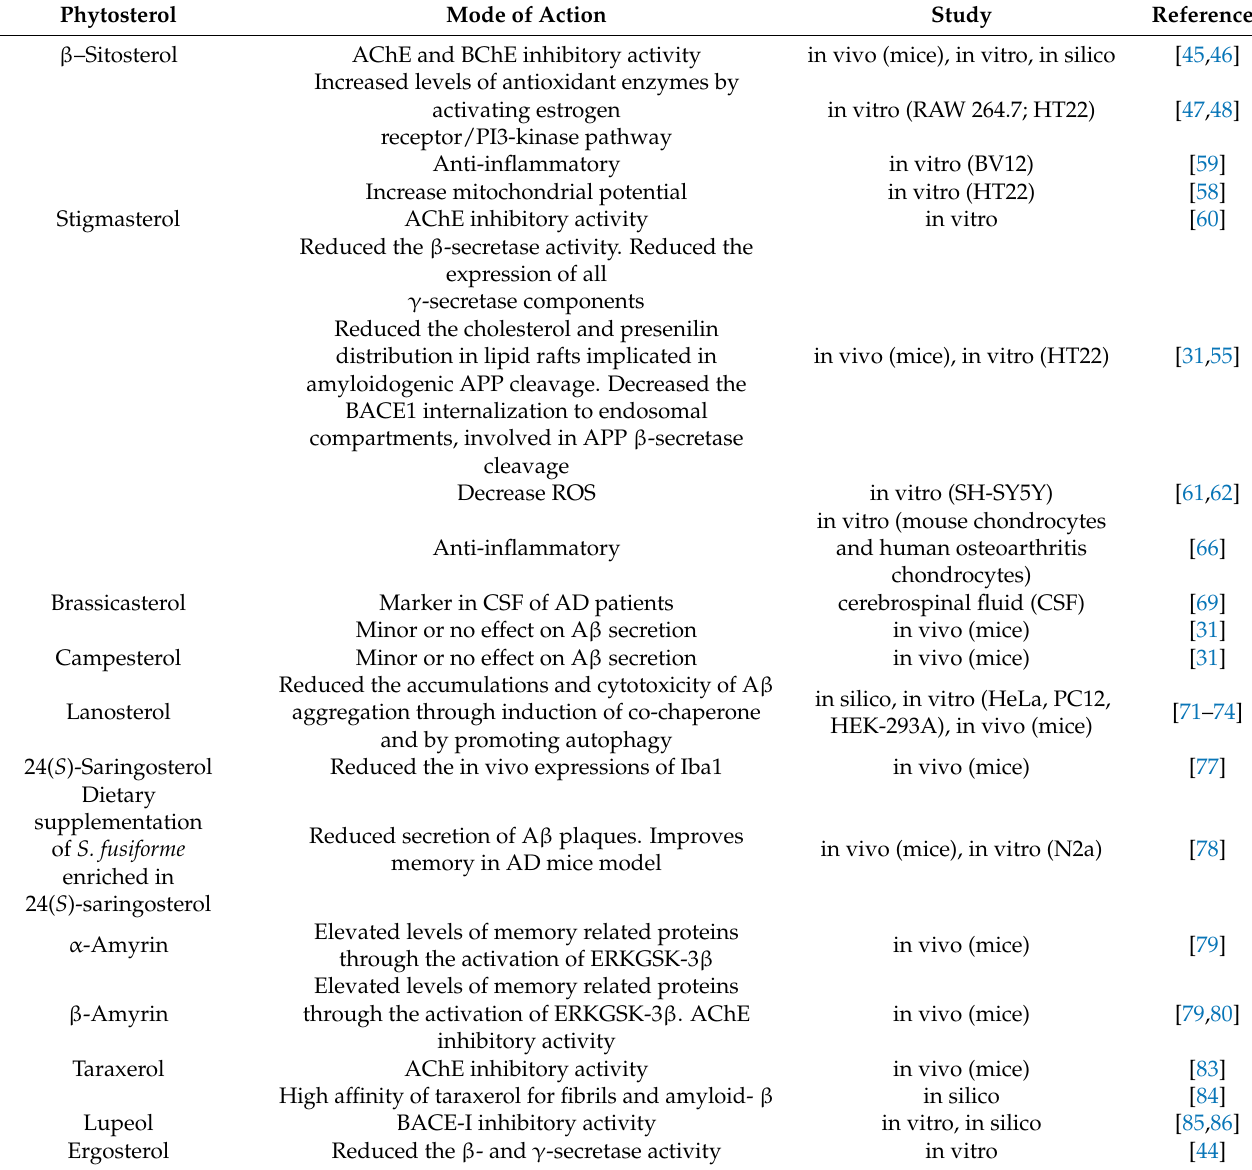
Table 1. Neuroprotective mechanisms of the reported